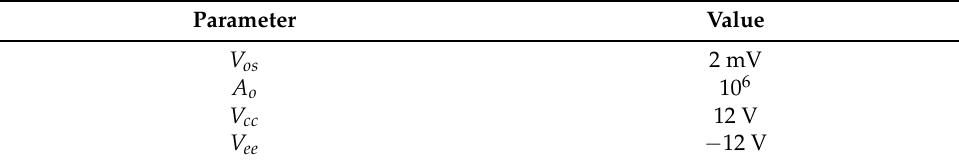
Table 9. Common parameters used in SPICE